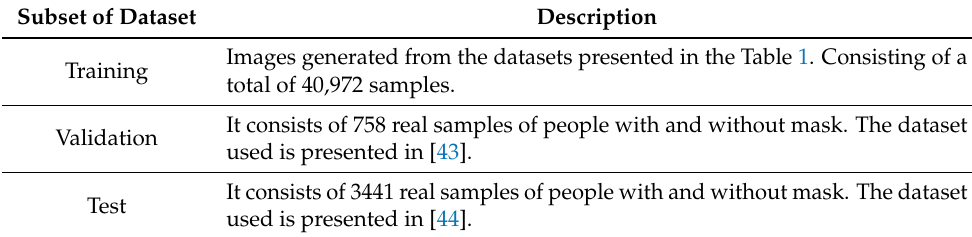
Table 4. Description of each subset of dataset used to detect presence or absence of masks.